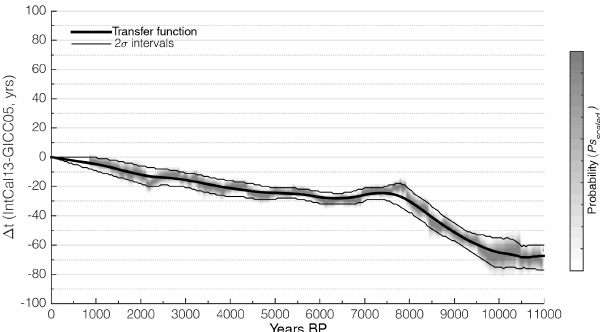
Figure 9. IntCal13-GICC05 age transfer function (thick black line) and its 2 σ confidence intervals (thin black lines) based on the prob- ability distributions ( P s ( t s ), grey shading) obtained from com- scaled paring the GRIP 10 Be-based (cid:49) 14 C (mean of concentration, flux and climate corrections) and IntCal13 (cid:49) 14 C